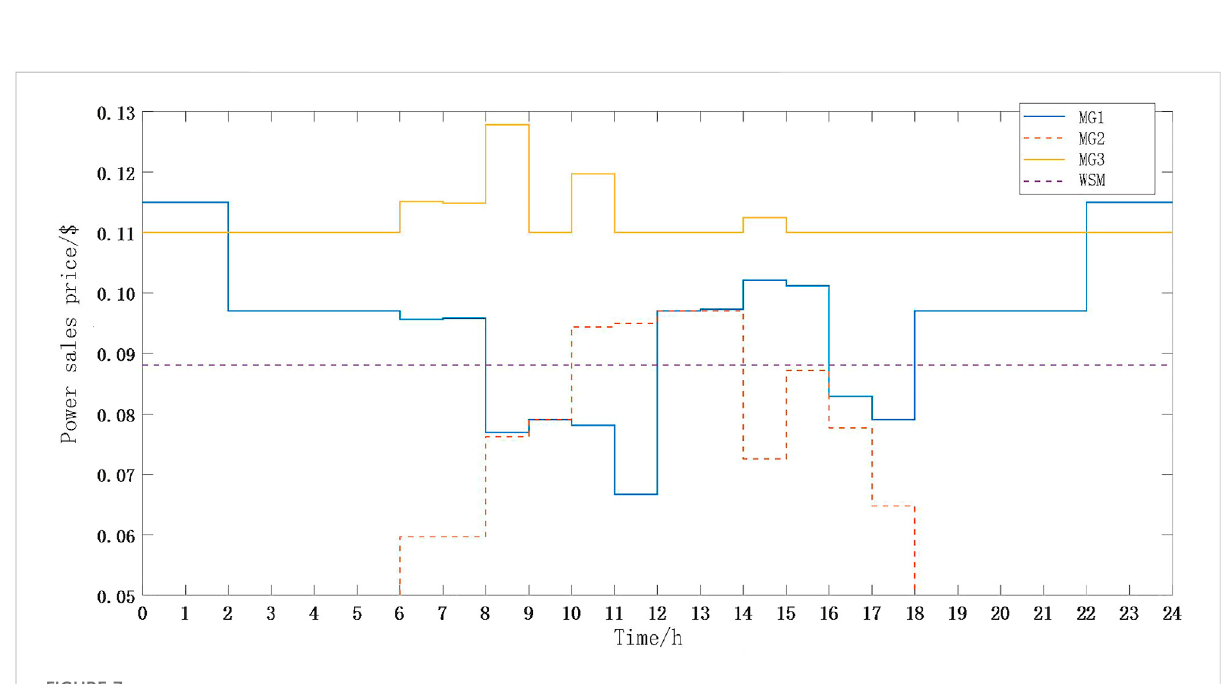
FIGURE 6 Share of electricity sold by each power seller.